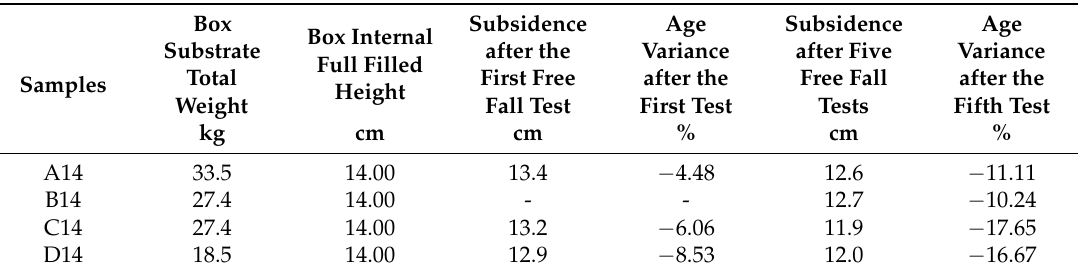
Table 2. Results obtained during the test campaign on growing media samples to validate the use of the laboratory compaction device.